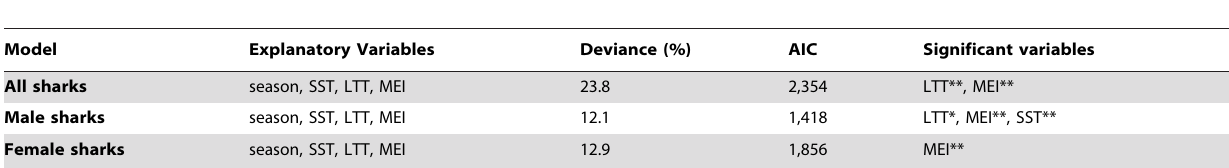
Table 7. The results of the generalized linear models for all sharks, males, and females including deviance, Akaike Information Criterion and significance of the variables.